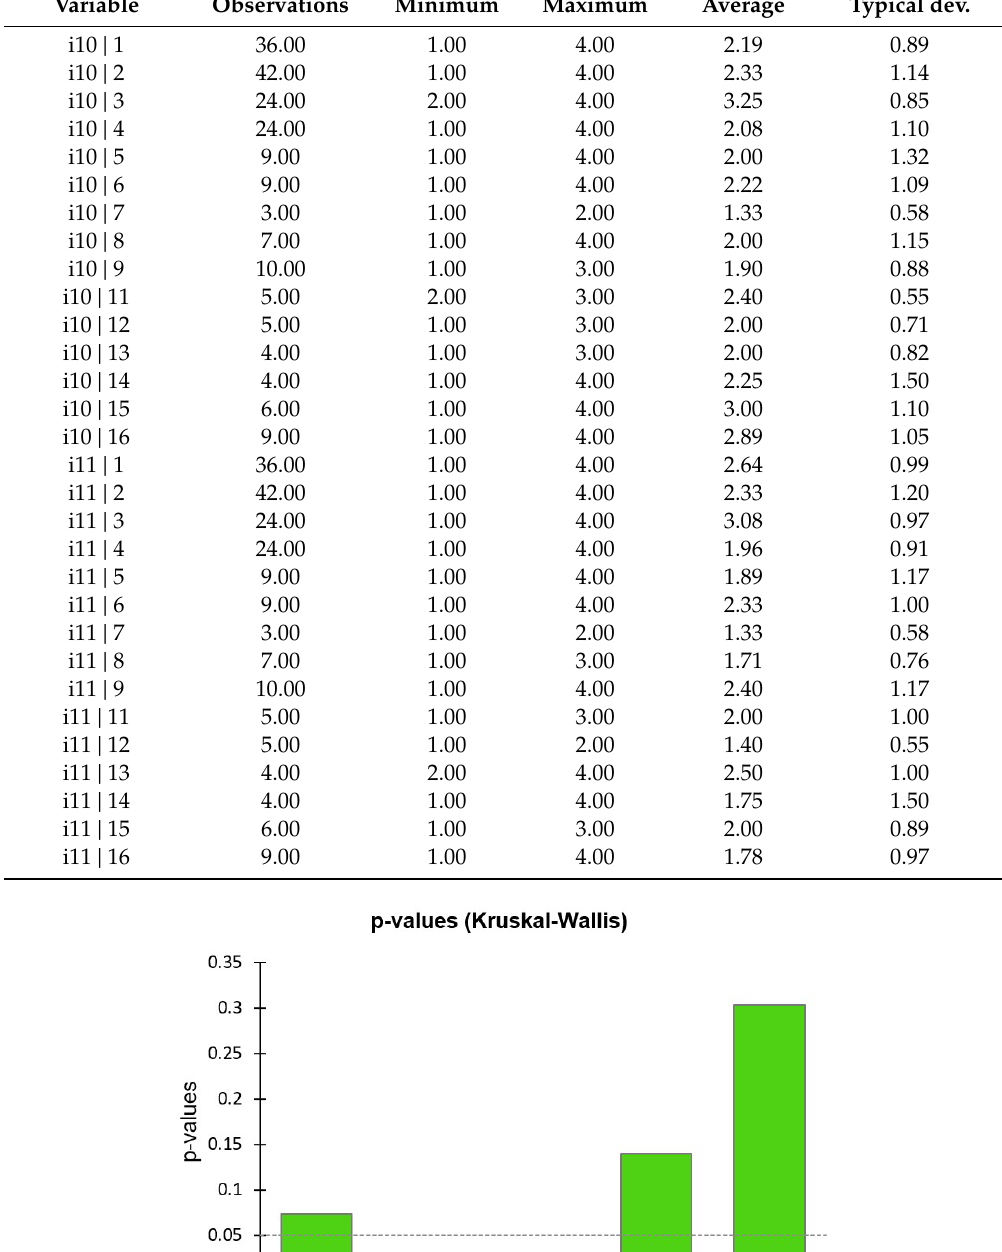
Table 11. Average di ff erences between Items 10 and 11 according to type of project.